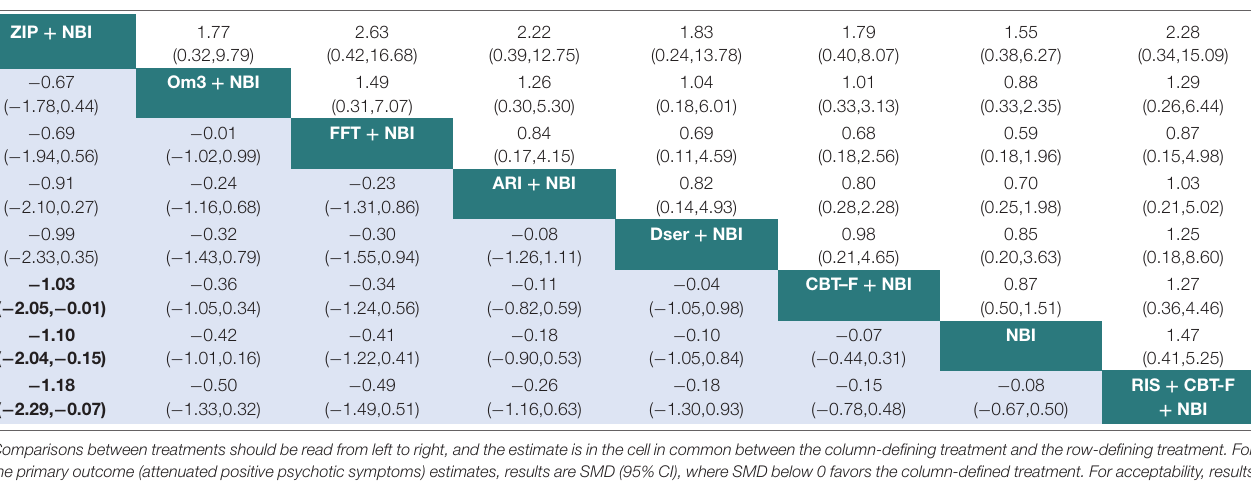
TABLE 3 | Network meta-analytic relative treatment effects for efficacy and acceptability at 6 months. ZIP + NBI